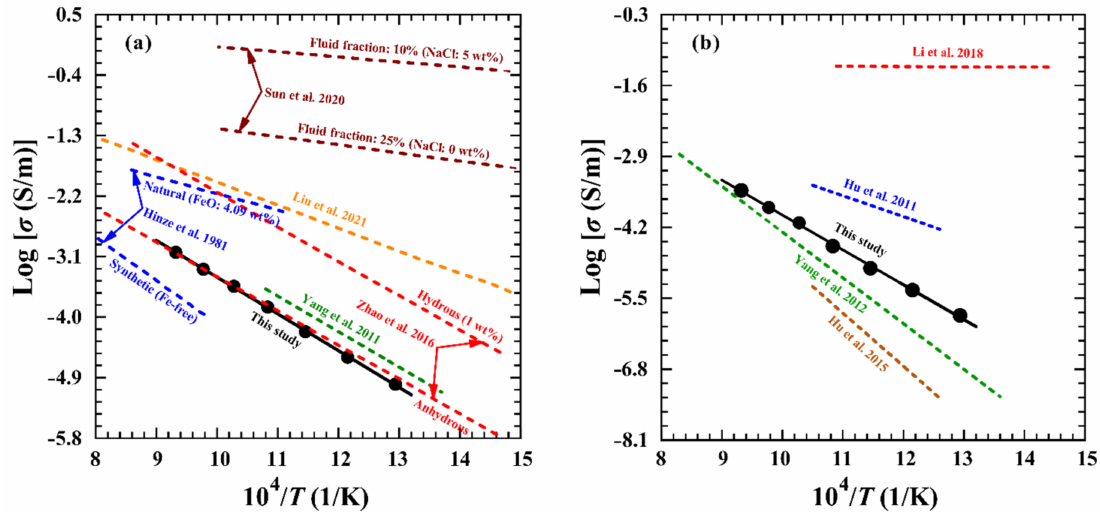
Figure 9. Comparisons of the electrical conductivities of dry clinopyroxene ( a ) and dry plagio- clase ( b ) at temperatures of 773–1073 K and 1.0 GPa in present studies with previous results, re- spectively. The electrical conductivity data for clinopyroxene are from Yang et al. (2011) [11], Zhao et al. (2016) [12] Hinze et al. (1981) [13], Liu et al. (2021) [14] and Sun et al. (2020) [15]. The electrical conductivity data for feldspar are from Yang et al. (2012) [16], Hu et al. (2011, 2015) [17,18], Li et al. (2020)